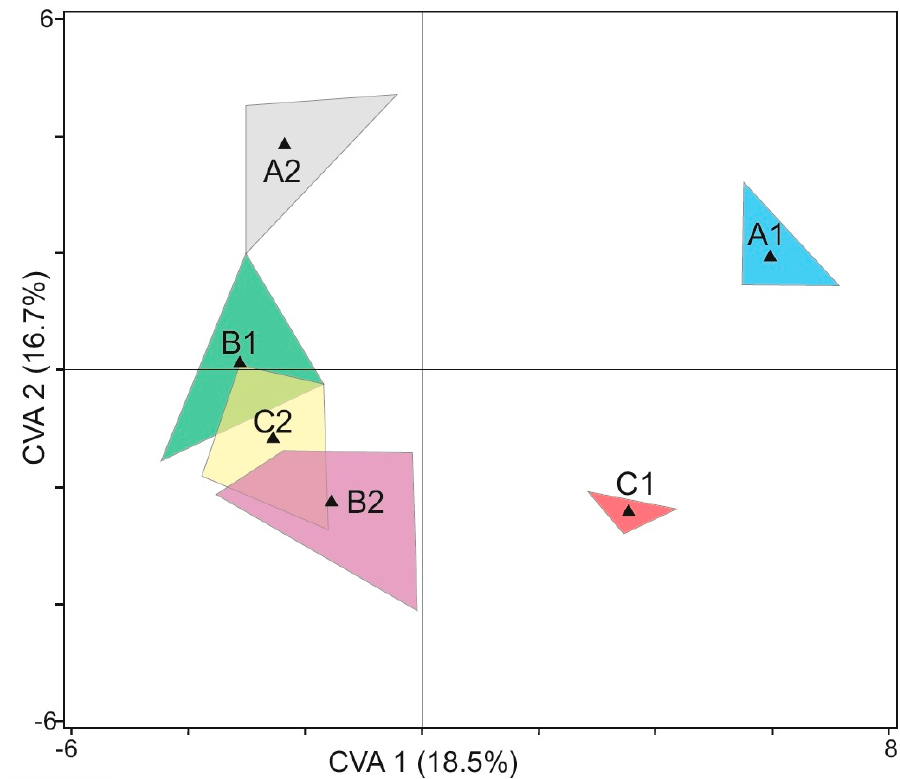
Figure 7. Distribution of combinations of treatments in two first canonical varieties. Variants of experiment: row spacing/seeding density: A1 (15/70), B1 (15/90), C1 (15/110) and A2 (30/70), B2 (30/90), C2 (30/110). Black triangles represent centroids for each cluster (variants of the experiment).